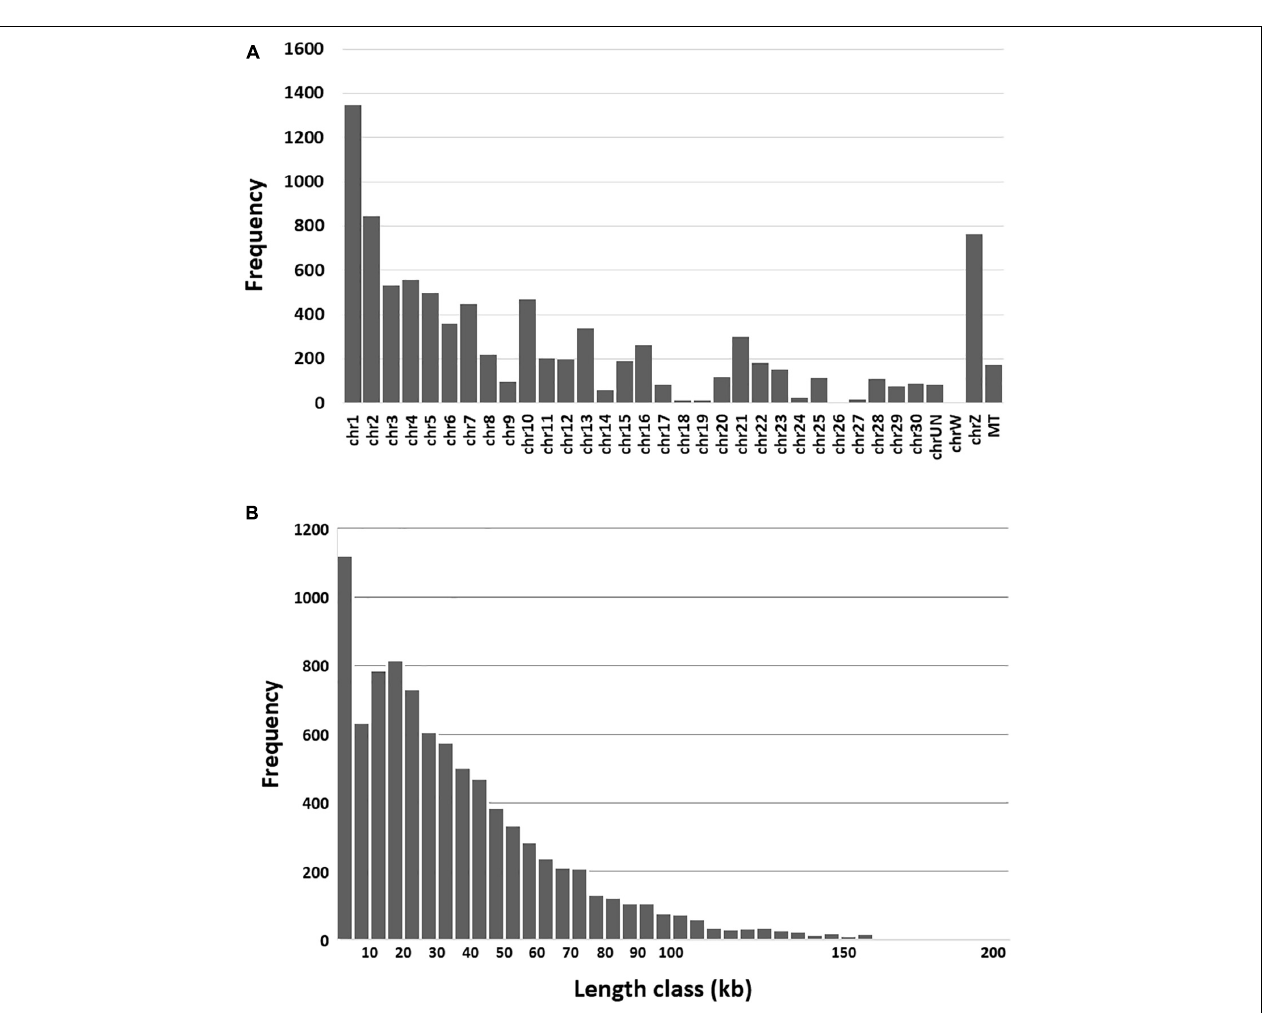
FIGURE 1 | (A) Frequency of predicted circRNAs by chromosome. (B) Frequency of circRNAs by length class. Each vertical bar represents a window of 5 kb in